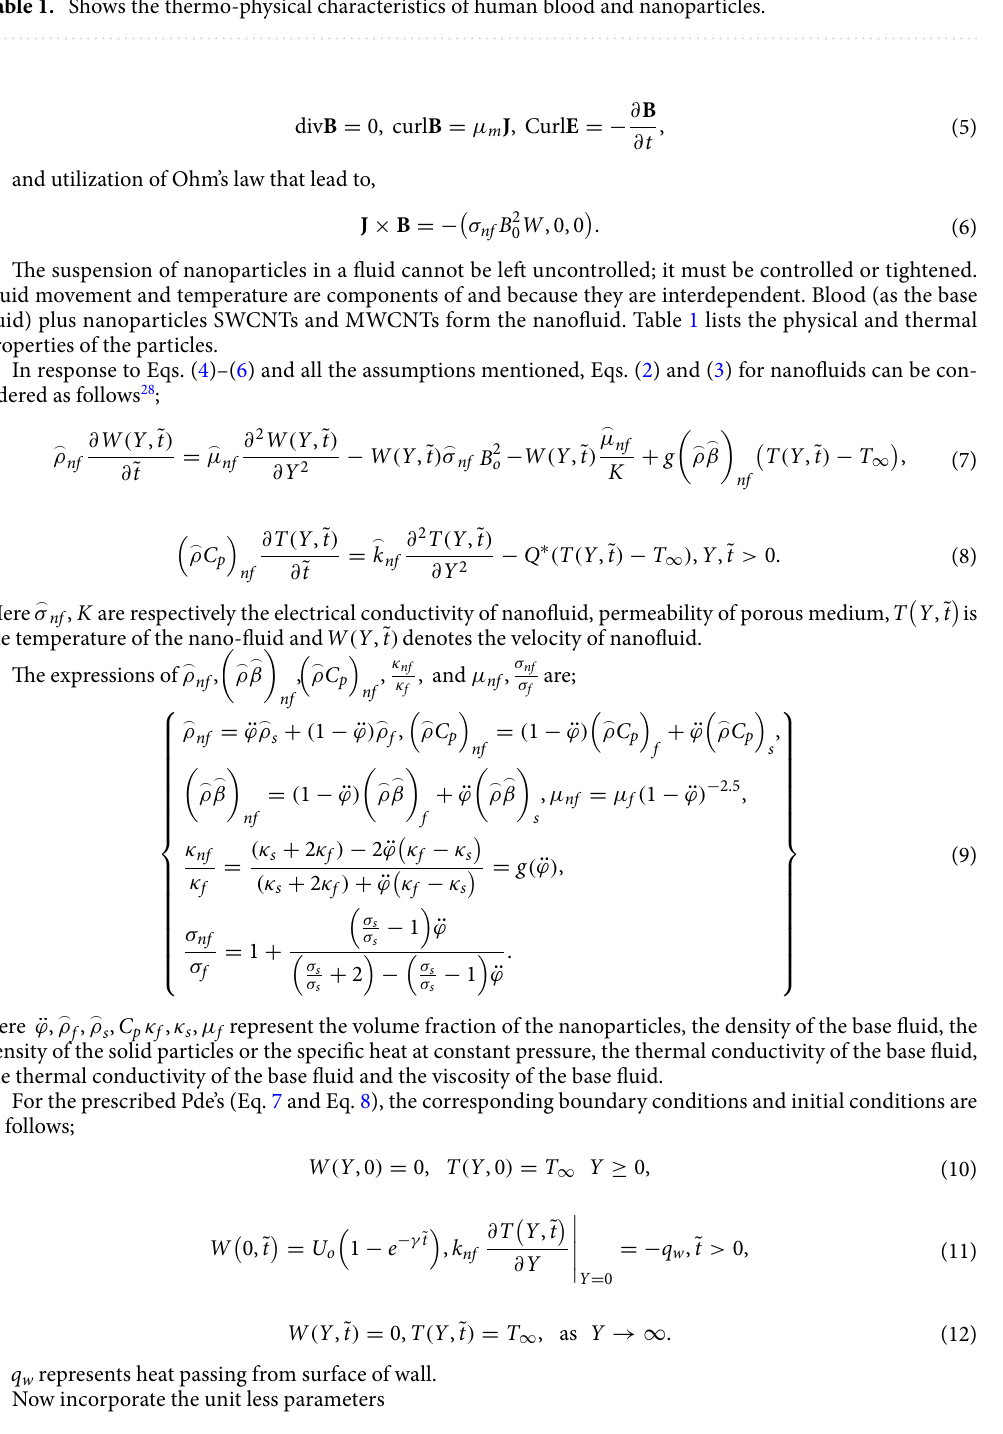
Table 1. Shows the thermo-physical characteristics of human blood and